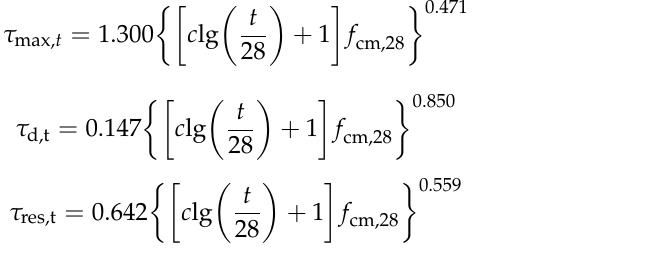
Table 4. Comparison results between test and calculated values of bond strengths. τ max,t τ d,t τ res,t No. M40 M31 M24 M40 M31 M24 M40 M31 M24 Average ratios of test to the calculated values